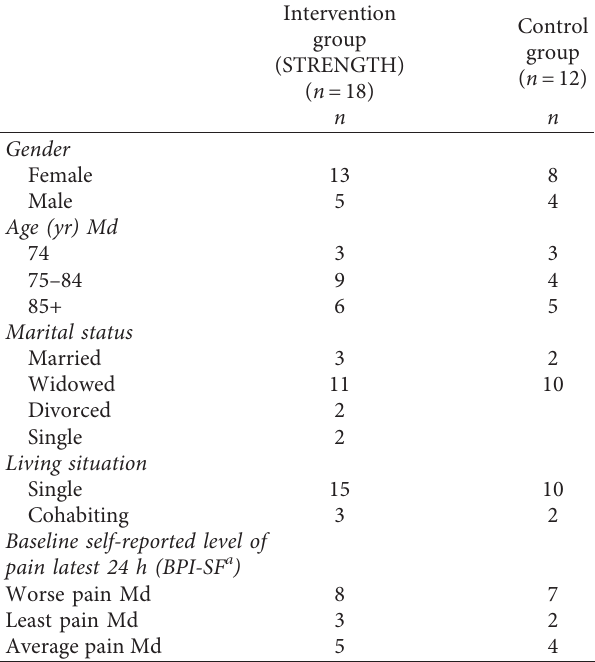
between the STRENGTH intervention group and the control group over time (F (1.27) � 4.269, p � 0 . 049, partial eta 2 � 0.14) (see Figure 2(a)).